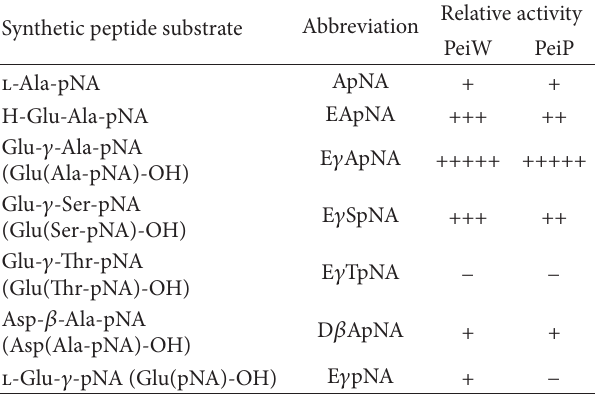
Table 2: Substrate specificity, activity of PeiW or PeiP on synthetic peptide substrates using an agarose plate assay. The intensity of a zone of yellow colouration was compared; − no zone, + zone being only just observable, and +++++ very large zone. No yellow zones were observed with control buffer in the